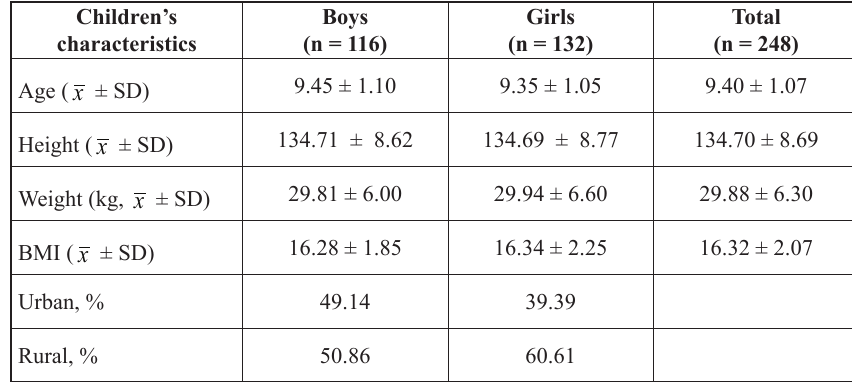
Table 1. Characteristics of study